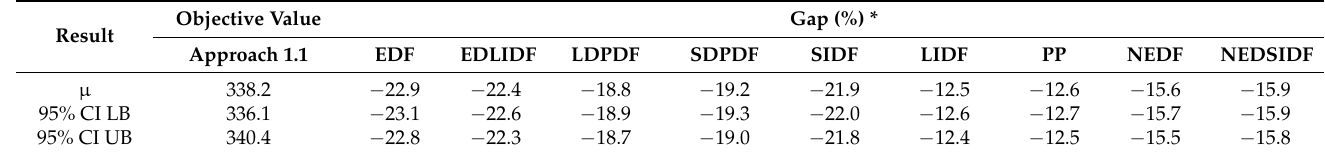
Table 10. The gap between the solution of the SDSMO model with clustering and the sequencing